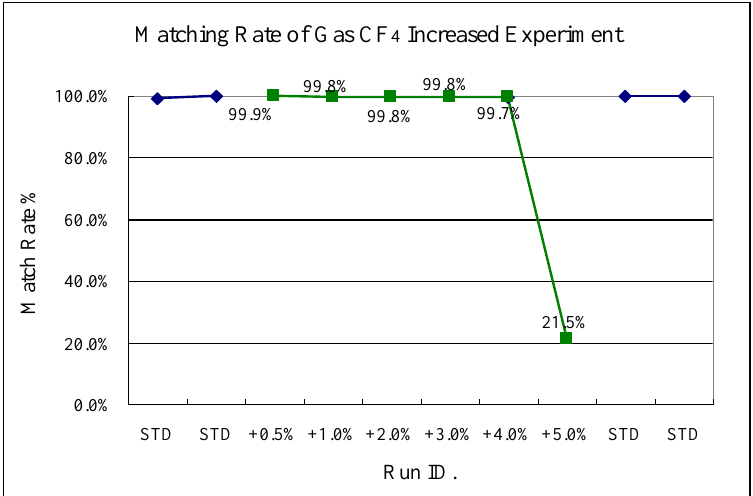
Figure 12. Experiment 3, CF 4 variance tested from 70.35 to 73.5 sccm. (STD = 70 sccm). Matching Rate of Gas CF 4 Increased